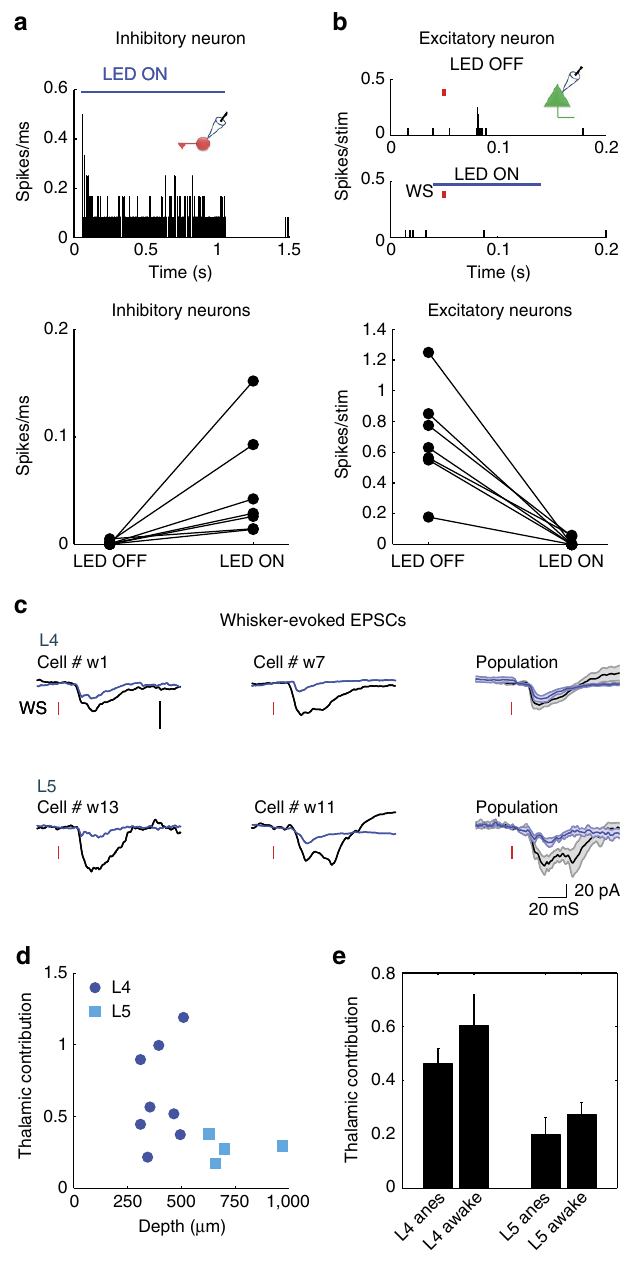
Figure 5 | The contribution of thalamic input to whisker-evoked cortical response in awake mice. ( a ) Peri-stimulus spike time histogram (PSTH) for an example GAD þ -ChR2 cell in response to 1s LED illumination (top) and population mean firing rate of GAD/PV þ cells (bottom). ( b ) PSTH of a putative excitatory L4 cell in response to whisker stimulation (red bar) in LED OFF and LED ON conditions (top) and population average spike count per stimulus of cells located in layers 4 and 5. ( c ) Average whisker-evoked EPSCs of two examples L4 (top) and L5 (bottom) cells recorded independently during LED OFFand LED ON conditions. To the right are the average EPSCs of the two populations. The two vertical scale bars represent 20pA. ( d ) Population depth profile of the thalamic contribution to the EPSCs of all recorded neurons ( n ¼ 12). ( e ) Mean population data of the thalamic contributions in L4 and L5 of awake and anaesthetized